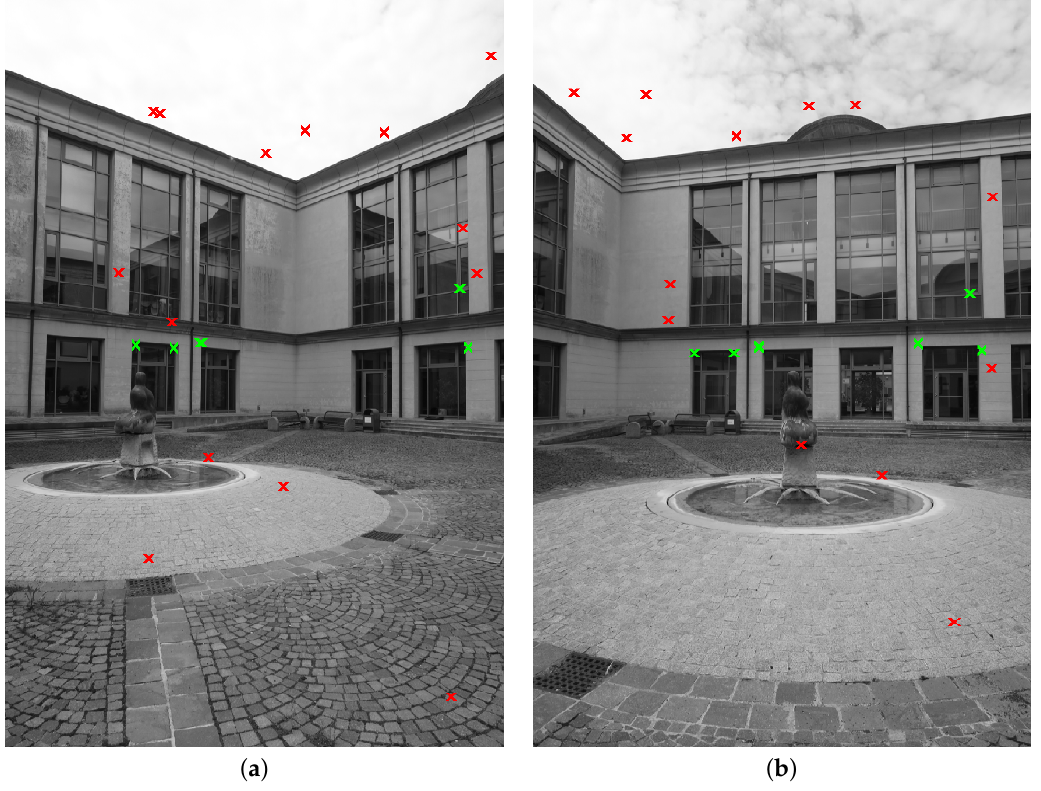
Figure 8. Incorrect matches ( red and green x -marks) obtained with the method proposed in Section 2 in two images, ( a ) and ( b ), of the second case study. Errors related to repetitive shapes are shown as green x -marks.